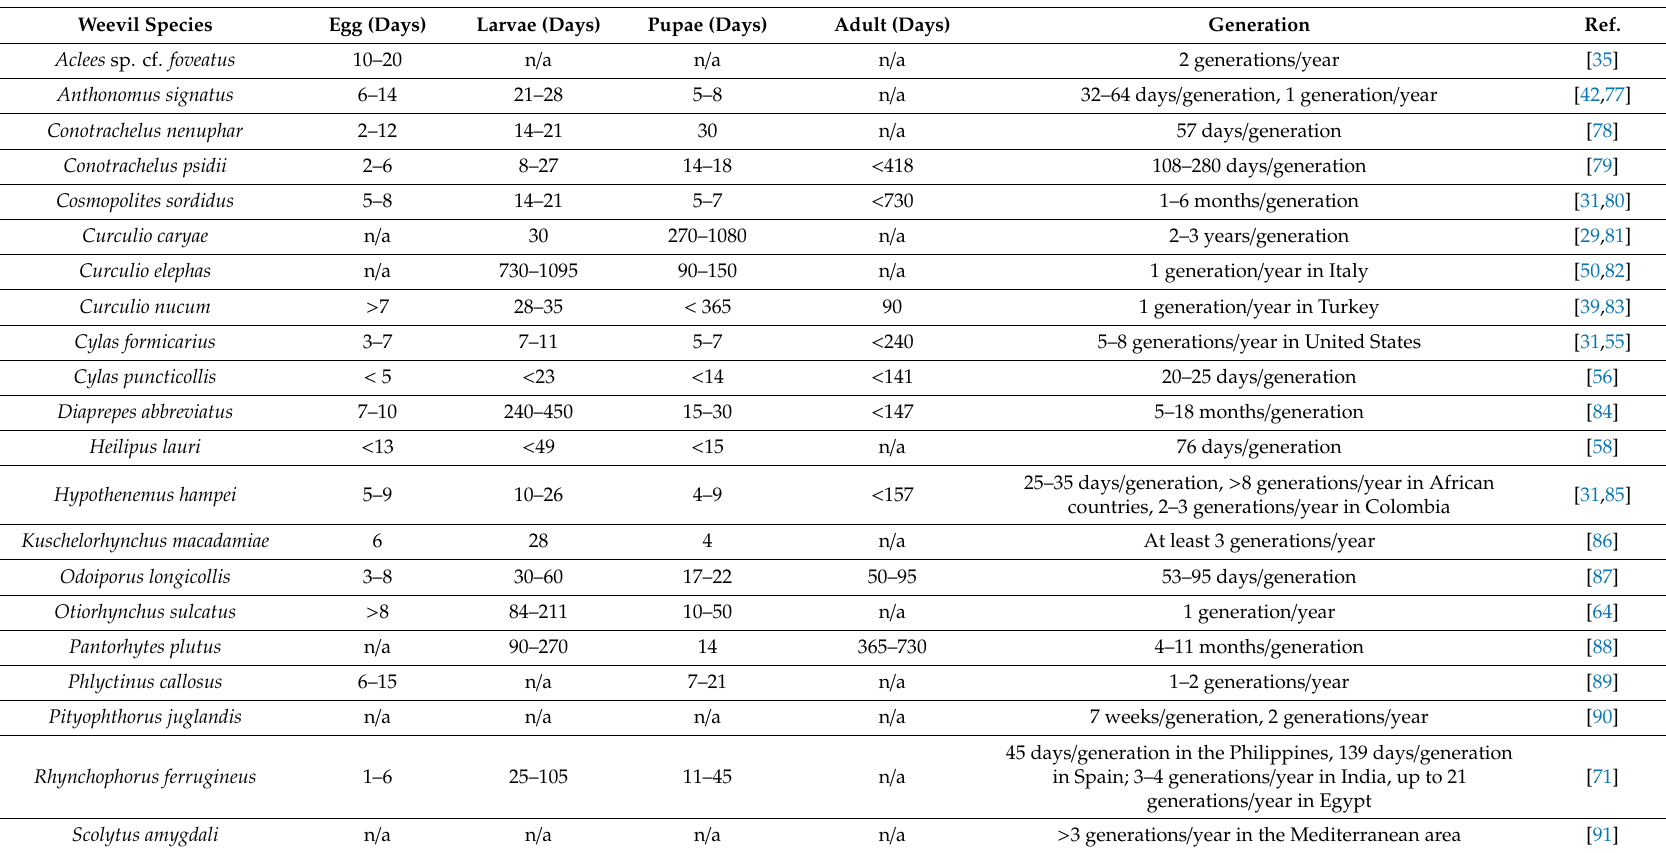
Table 2. Weevil life stage durations (where known) for important horticultural pest species used in experiments with EPF. Weevil